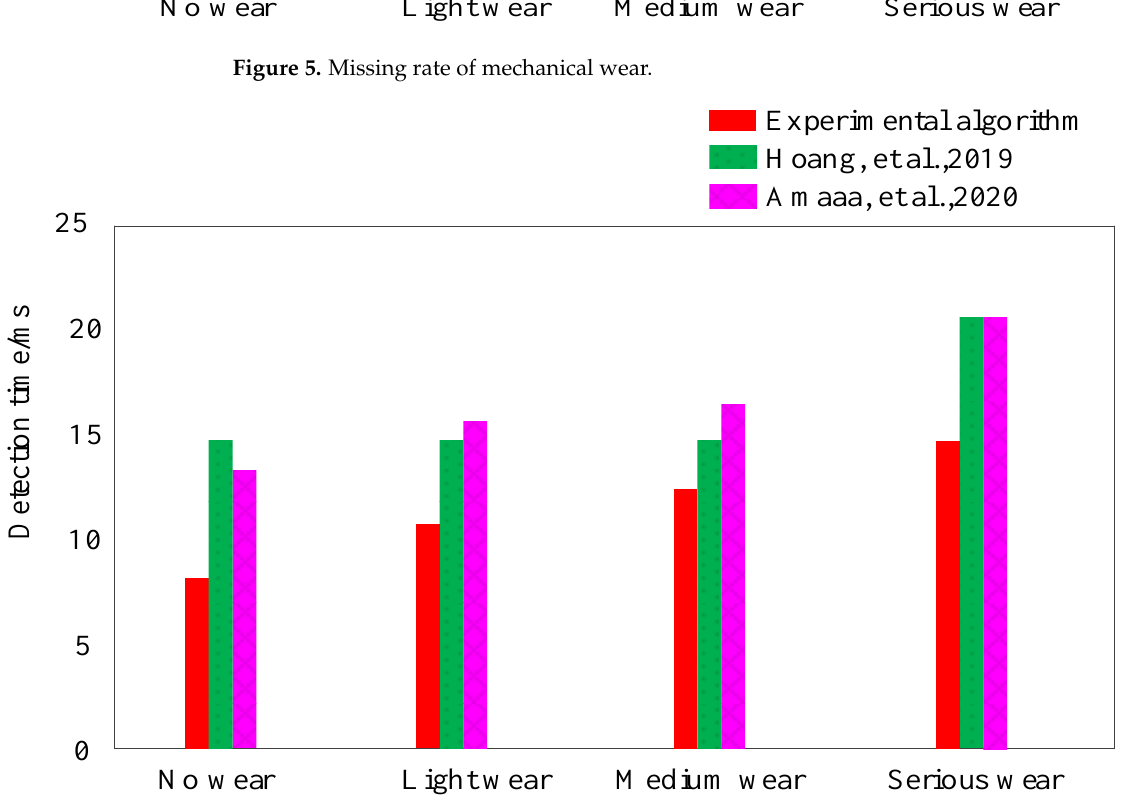
Figure 6. Detection time of mechanical wear.